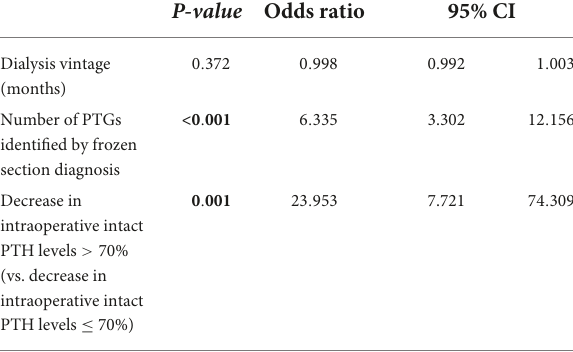
TABLE 5 Multivariate logistic regression analysis for successful